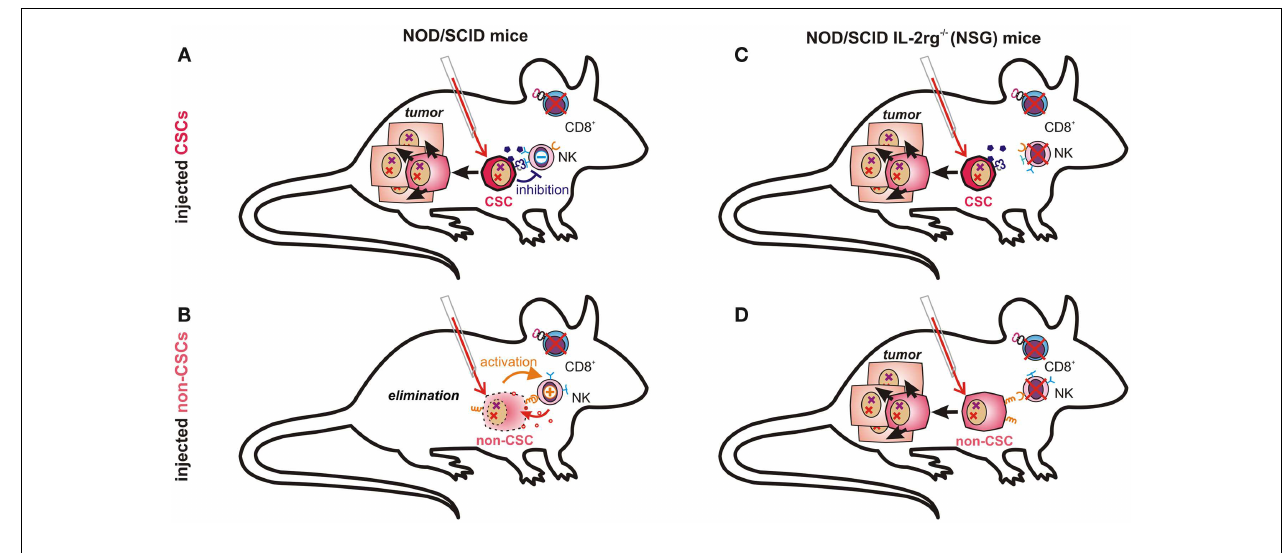
immunosuppressive molecules may, however, be recognized and eliminated by host NK cells (B) . In NOD/scid IL2rg − / − (NSG) mice, which also lack NK cells, both poorly immunogenic CSCs (C) and further differentiated cancer cells (D) can seed tumors, as malignant progenitor cells may also possess enormous proliferative